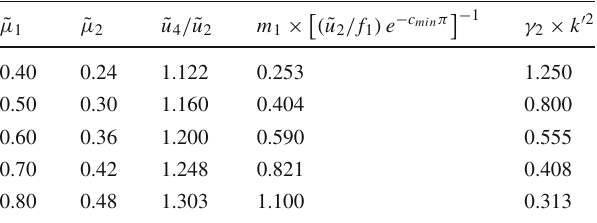
Table 2 Estimates of the O (TeV) radion masses corresponding to the parameter values from Table 1 (computed using (45)), and the corre- sponding values of the higher curvature couplings associated with each choice of ˜ μ 1 , expressed in terms of the fundamental parameters of the model which are not expected to be directly measurable in collider